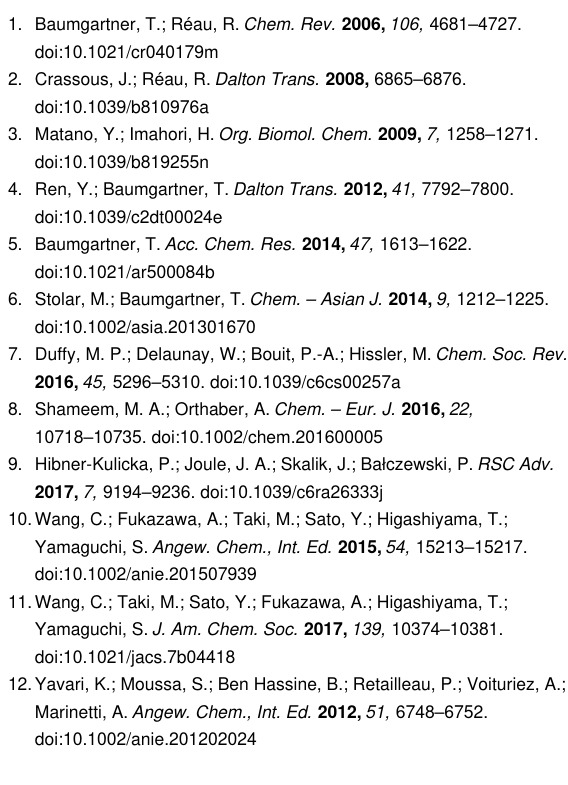
a Measured in CH 2 Cl 2 at 5 × 10 − 6 M. b Representative absorption maxima (sh stands for a shoulder peak). c Molar absorption coefficient for the longest-wavelength absorption maximum (except the shoulder). d Determined using quinine sulfate as the standard (54% in 0.1 M H 2 SO 4 ). e BP = 1-phenyl-2,3-dibutylbenzo[ b ]phosphole oxide. Data taken from [17]. f TP = triphenylene. Data taken from [32] ( λ abs and log ε ) and [33] ( λ em and Φ F ). g TP(OC 12 H 25 ) 2 = 2,3-di( n -dodecyloxy)triphenylene. Data taken from